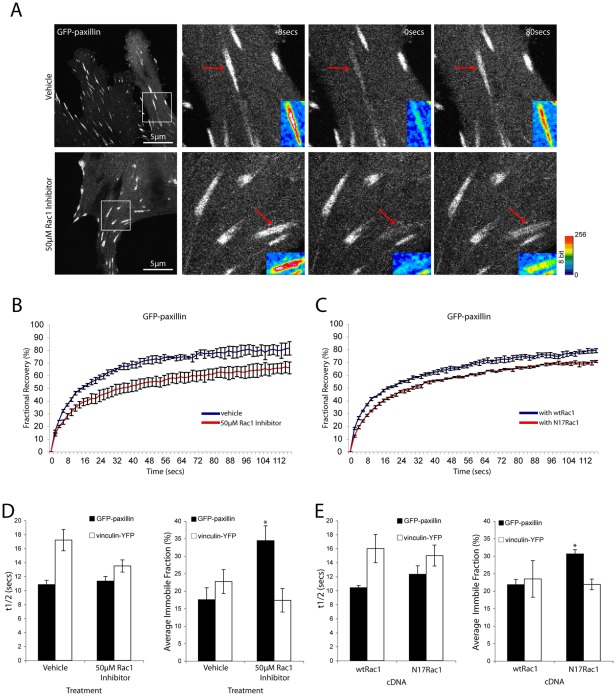
Rac1 inhibition specifically affects the dynamics of paxillin in adhesions.(A) Images of FRAP time series of GFP-paxillin-expressing NIH 3T3 cells ±50 μM Rac1 inhibitor. Inset are pseudo-colored images of the adhesions undergoing FRAP analysis highlighting a reduction in the GFP-paxillin recovery. (B) Compiled fluorescence recovery curves for GFP-paxillin in adhesions from n = 3 individual experiments ± 50μM Rac1 inhibitor and (C) with wtRac1 or N17Rac1. (D) Quantitation of the t1/2 of fluorescence recovery and immobile fraction for GFP-paxillin and vinculin-YFP ±50 μM Rac1inhibitor. (E) Quantitation of the t1/2 of fluorescence recovery and immobile fraction for GFP-paxillin and vinculin-YFP with wtRac1 or N17Rac1. FRAP analyses reveal a significant increase in the immobile fraction of GFP-paxillin, but not vinculin-YFP in cells with decreased Rac1 activity. Error bars are standard error of the mean. * = p<0.05.